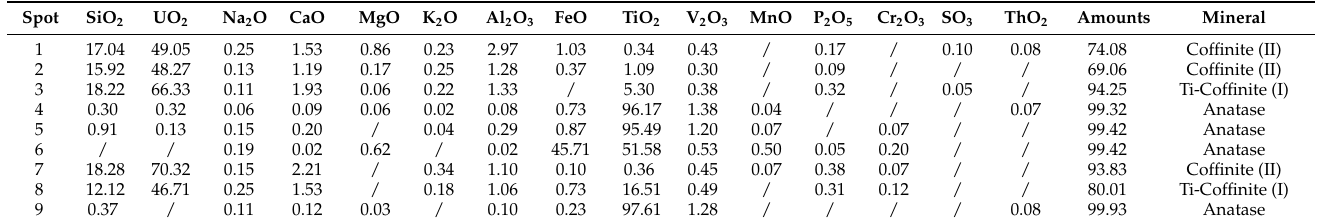
Table 1. Data of electron probing analyses for U minerals and the alteration product of ilmenite in sandstone-hosted U deposits in northern Ordos Basin.